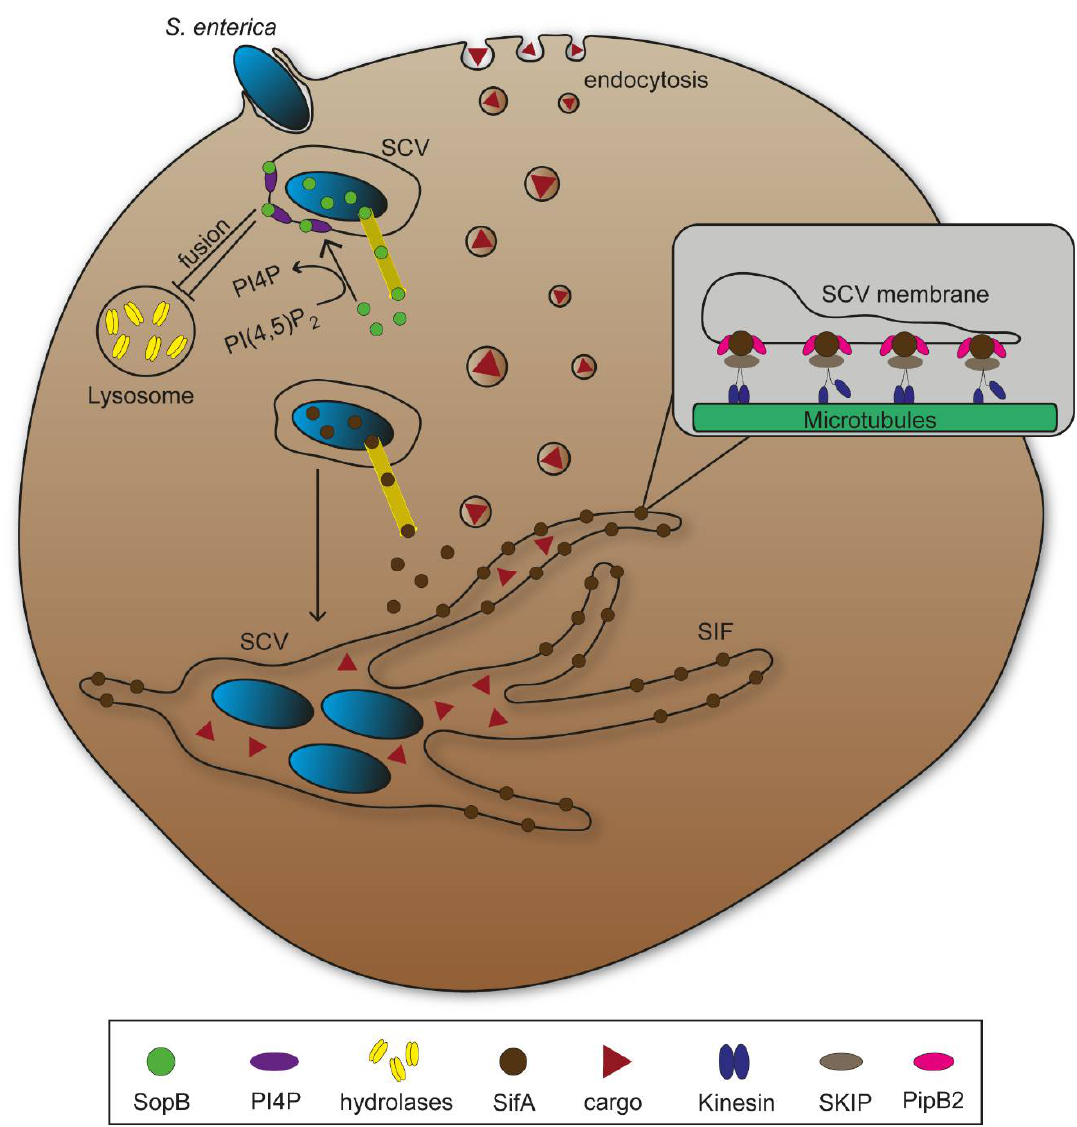
Figure 2. Manipulations of host cell endosomal system by intracellular Salmonella enterica . Once internalized, the bacteria rearrange their vesicular compartments to bypass lysosomal degradation. Type III secretion system (T3SS)-secreted effector protein SopB mediates dephosphorylation of membrane lipid phosphatidylinositol-4,5-bisphospate (PI(4,5)P2) generating phosphatidylinositol 4-phosphate (PI4P). Further infection progress shows secretion of effector protein SifA, which associates with the Salmonella -containing vacuole (SCV) membrane and leads to Salmonella -induced filaments (SIF) formation along microtubules through interactions with SifA-Kinesin-Interacting-Protein (SKIP). SIFs provide nutritional supply through interception of vesicle containing endocytosed cargo such as proteins or lipids resulting in S. enterica replication.